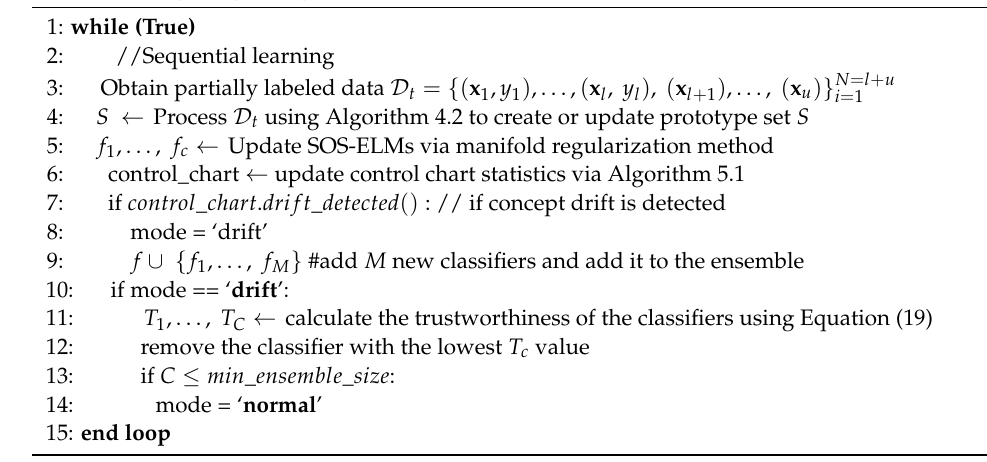
Algorithm 5: An Adaptive Prototype-Based Manifold Regularization Approach for Data Stream